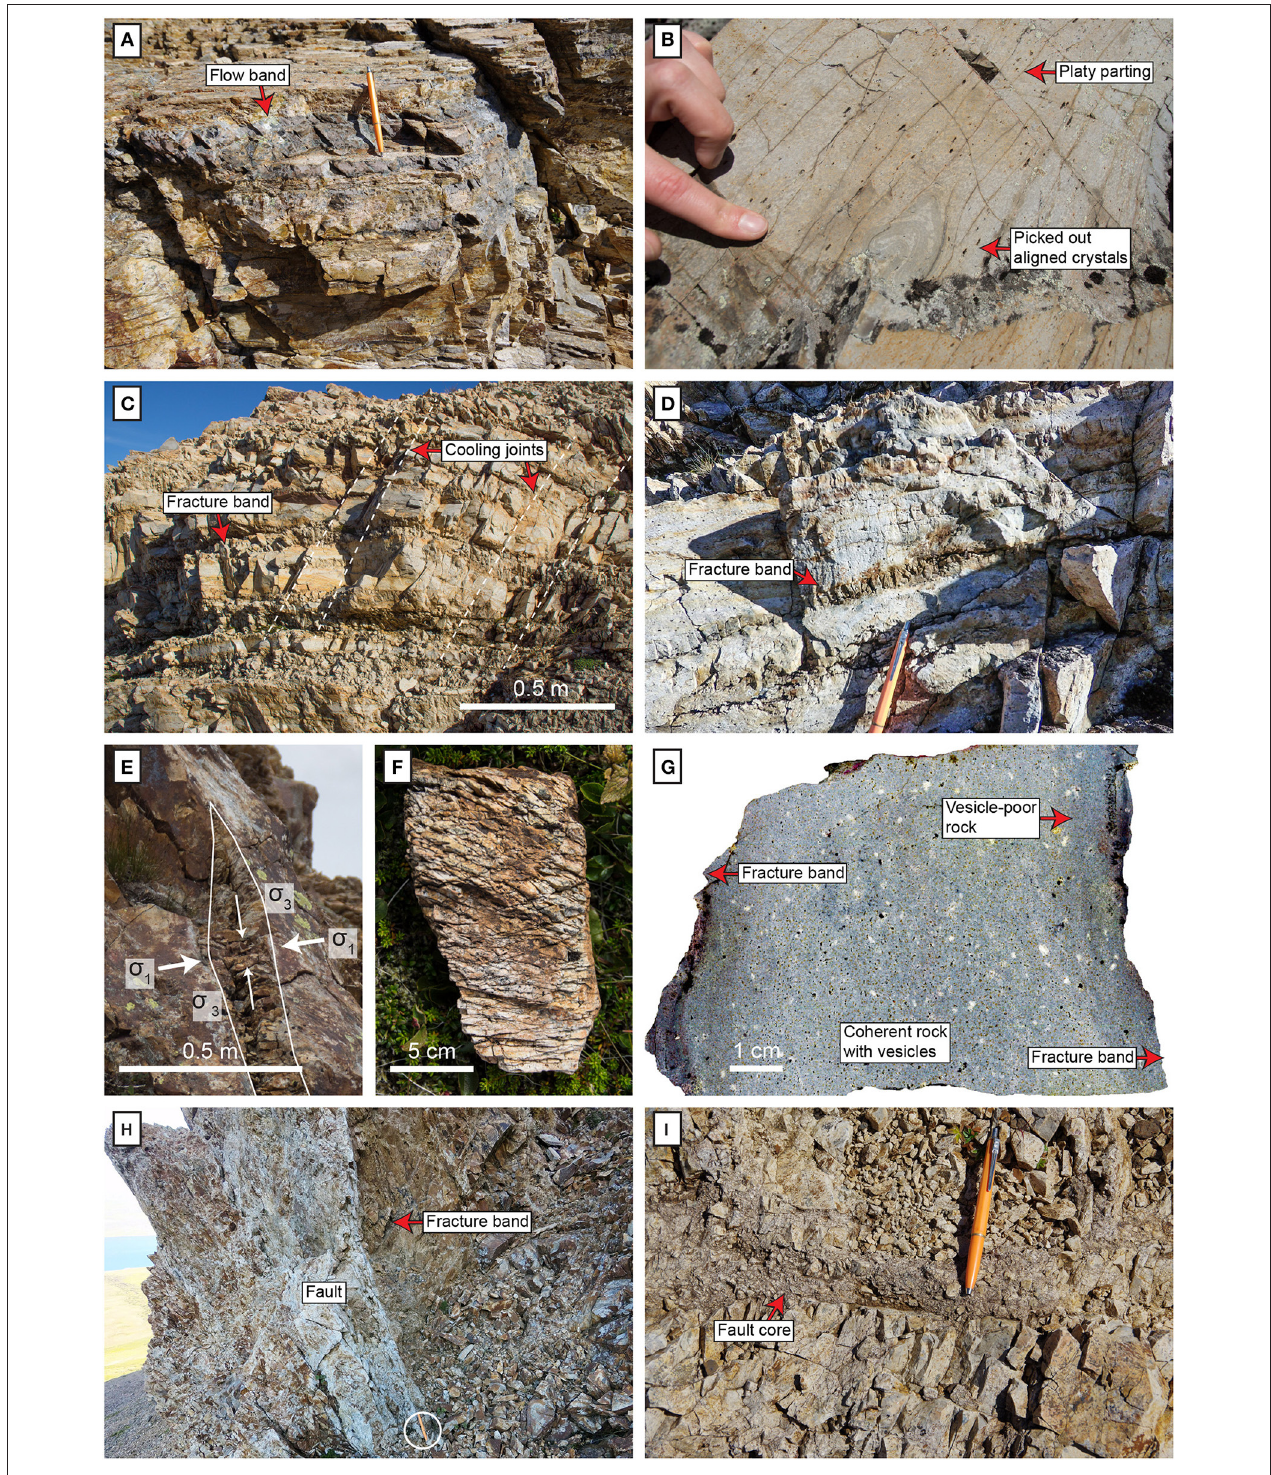
FIGURE 5 | (A) Flow bands in the Sandfell rhyolite on the southern slopes of Lower Sandfell. Flow bands are planes of varying color and crystallinity in outcrop and hand-specimen scale. The flow bands are not abundantly folded, which indicates that they were generated in the laccolith body as opposed to in the feeder. Pen for scale. (B) Flow fold and aligned hollows of picked-out crystals in rhyolite at Upper Sandfell. Note the platy parting parallel to the crystal alignment. (C,D) Fracture